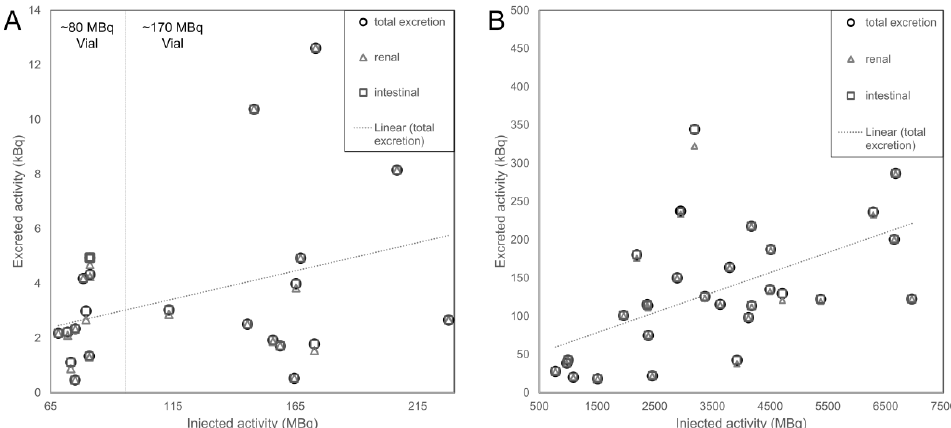
Figure 6. Correlation of absolute excreted to injected activity of 166 Ho after TARE planning (A) and TARE treatment (B) procedures.